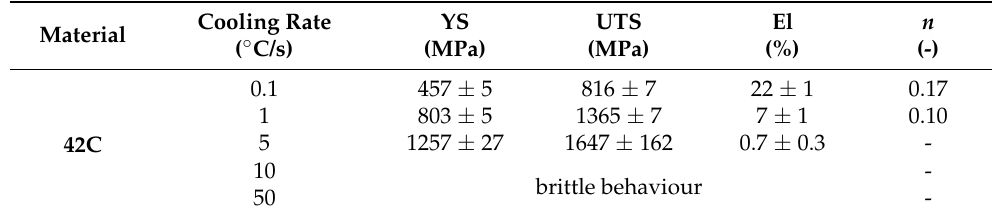
Table 3. Results of mechanical properties determined from mini-tensile tests for 42C according to the experimental cooling rates (YS: yield strength, UTS: ultimate tensile strength, El: total elongation at fracture, n : work-hardening exponent).